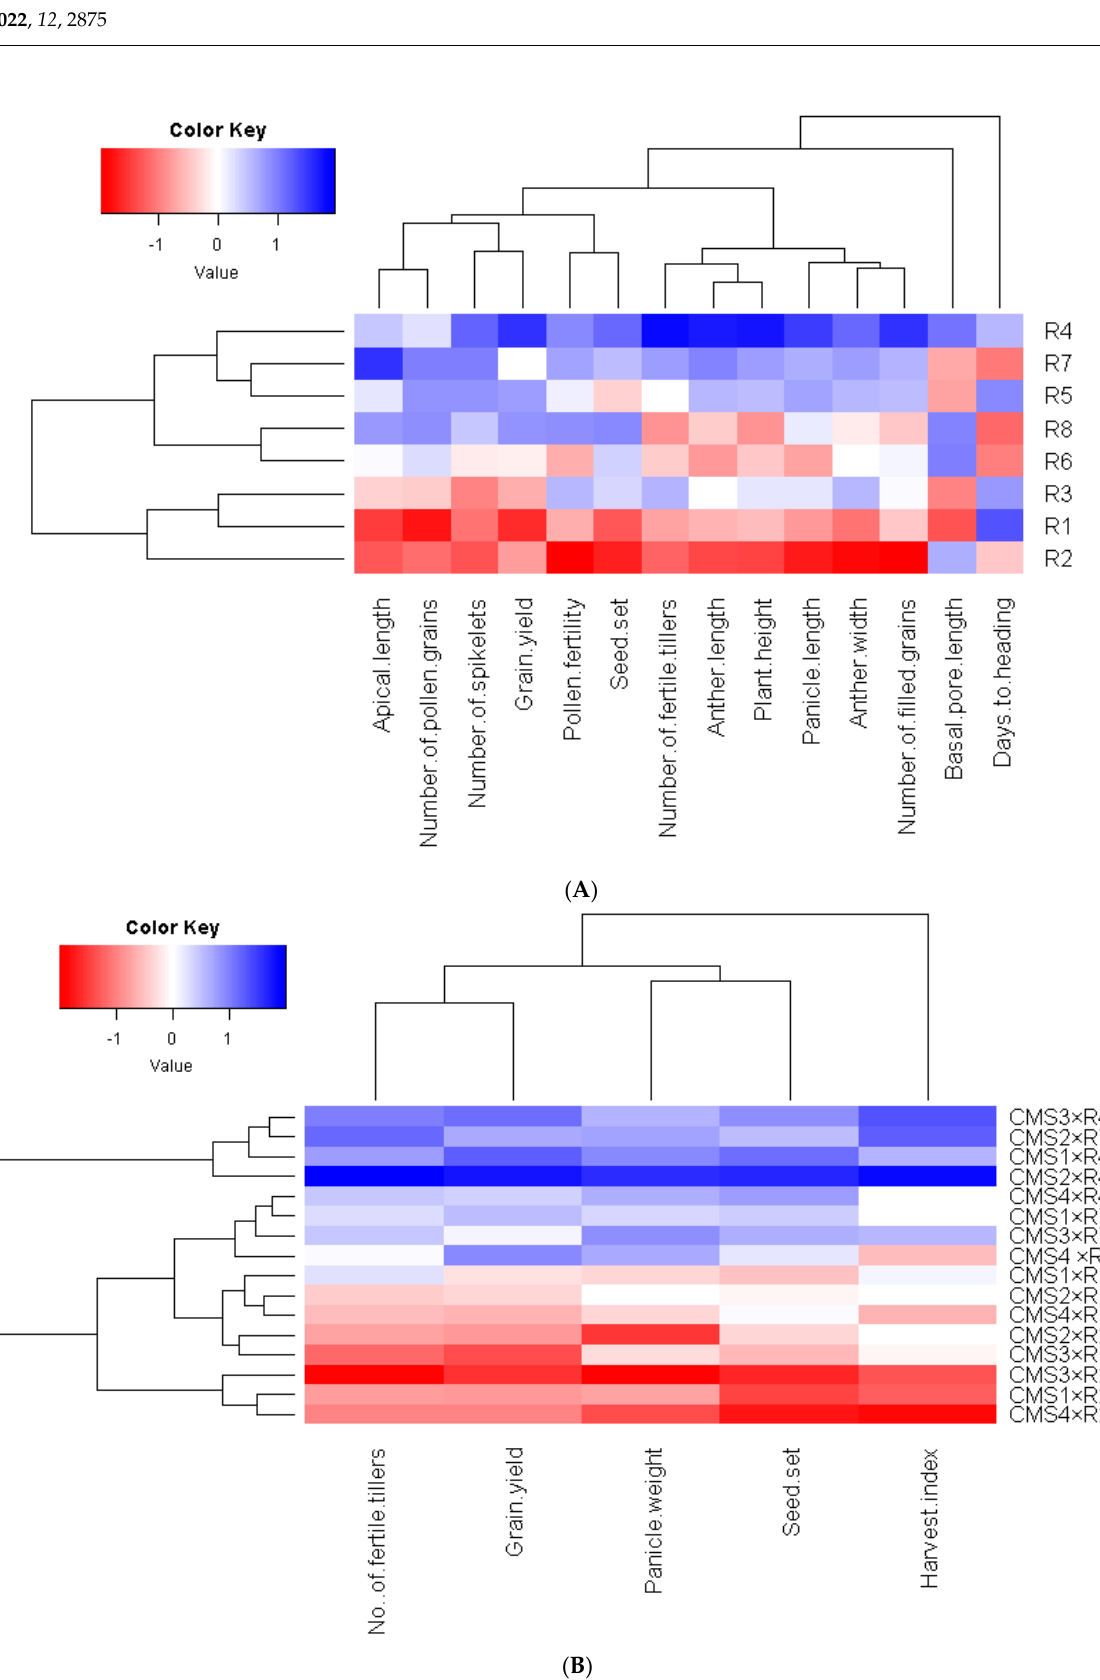
Figure 1. Heatmap and hierarchical clustering divided the evaluated restorer lines ( A ) and developed hybrid combinations ( B ) into different clusters based on the evaluated characteristics. Red and blue colors reveal low and high values for the corresponding characteristics, respectively.